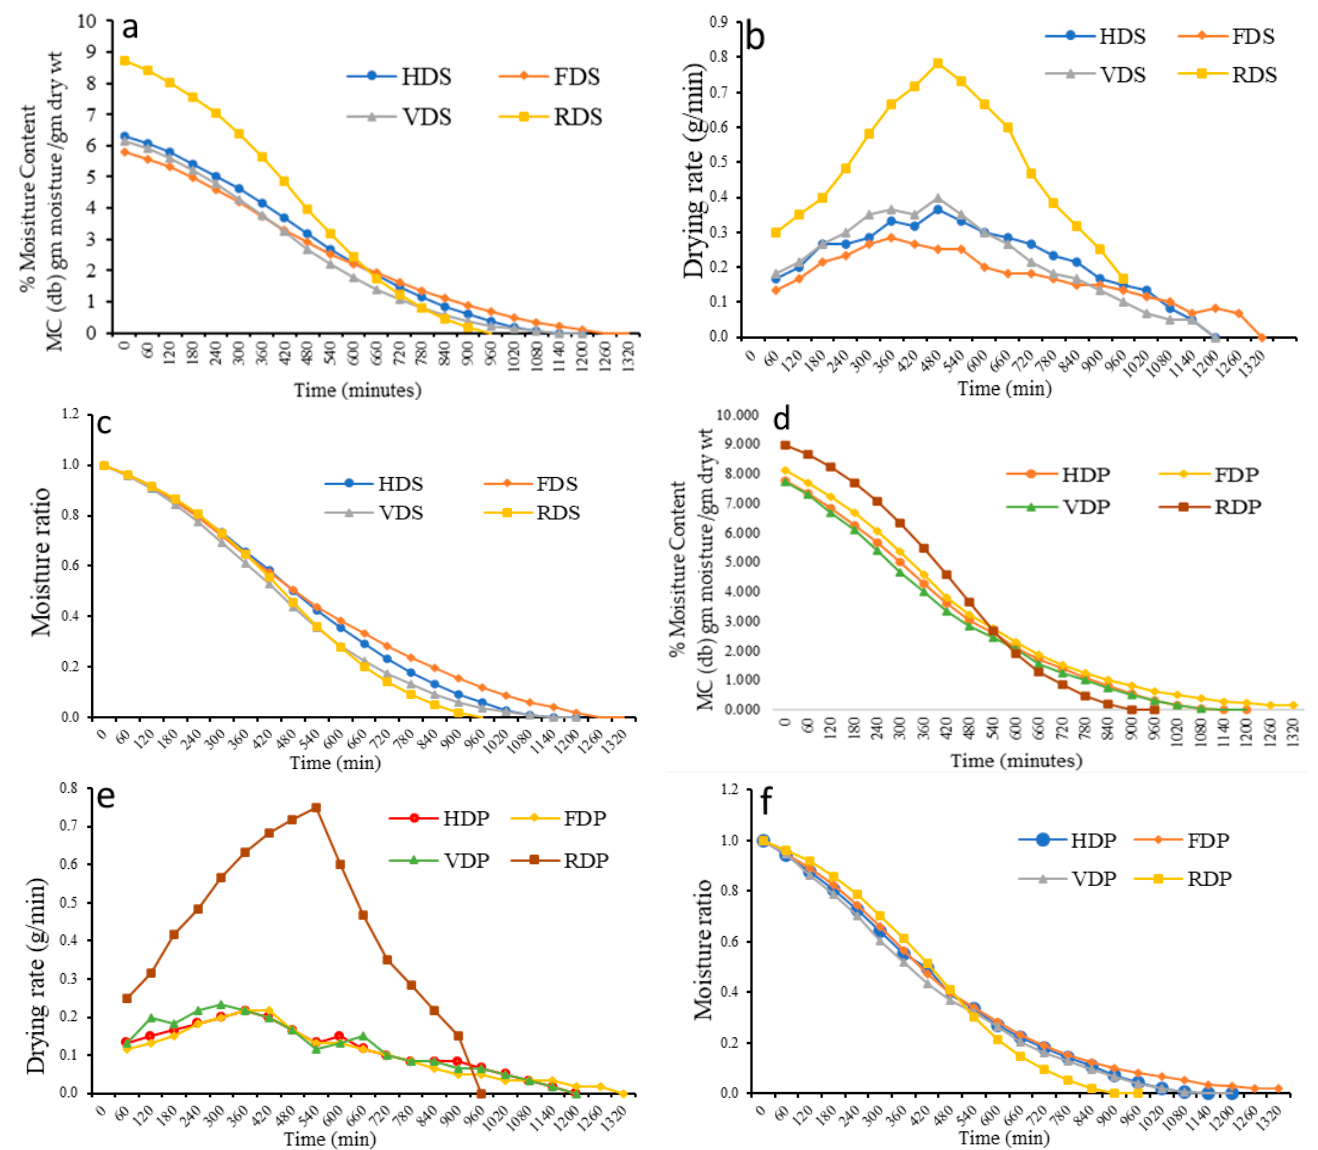
Figure 3. Graphical representation of slice samples: ( a ) % MC vs. drying time, ( b ) drying rate vs. drying time, ( c ) moisture ratio vs. drying time, and of pulp samples: ( d ) % MC vs. drying time, ( e ) drying rate vs. drying time, and ( f ) moisture ratio vs. drying time. MC, moisture content.